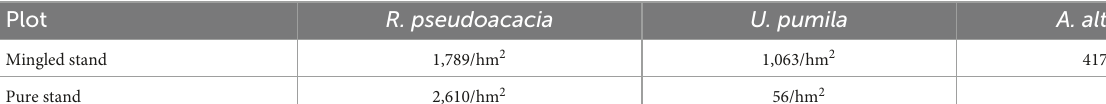
TABLE 2 Number of main tree species in the plot.